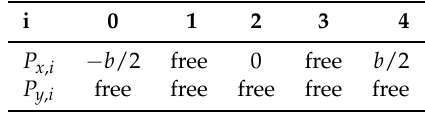
Table 1. Definition of the control points of the upper main spline n = 4.